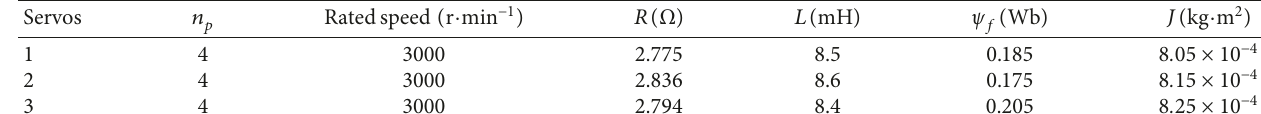
Table 1: Parameter settings of three servos.